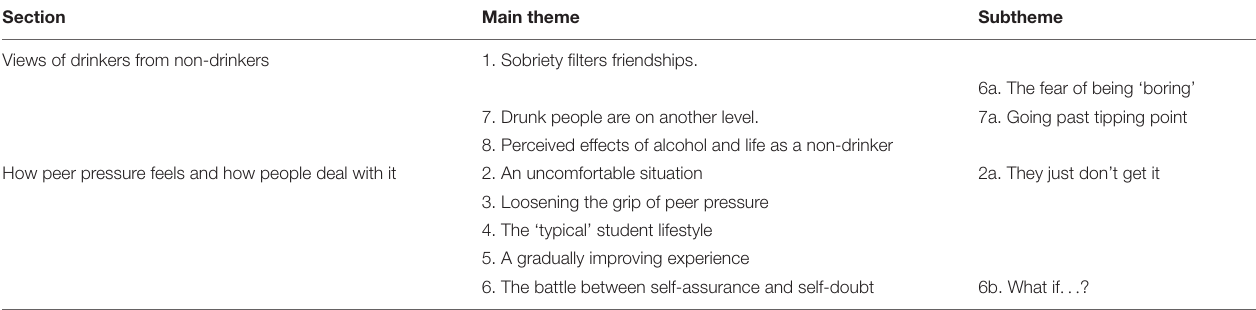
TABLE 2 | Summary of eight main themes and four subthemes included in two overarching sections. Section Views of drinkers from